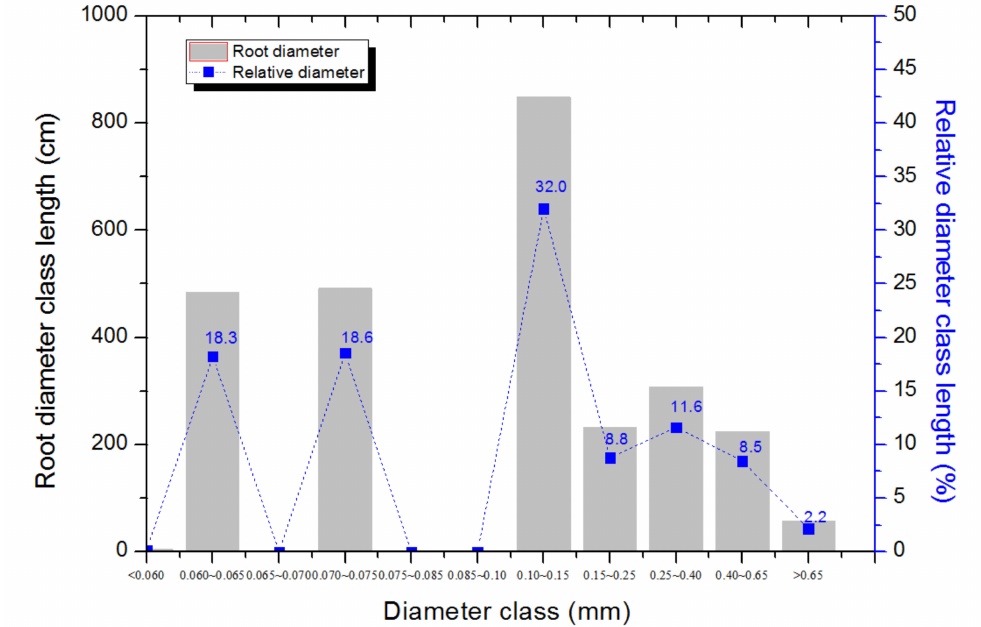
Figure 2. Root diameter class length (cm) (bars) and relative diameter class length (rDCL, %) (dotted lines) of 189 barley genotypes grown in the semi-hydroponic phenotyping system for 30 days after transplanting in a temperature-controlled glasshouse. Diameter class (mm) including <0.060, 0.060~0.065, 0.065~0.070, 0.070~0.075, 0.075~0.085, 0.085~0.10, 0.10~0.15, 0.15~0.25, 0.25~0.40, 0.40~0.65,